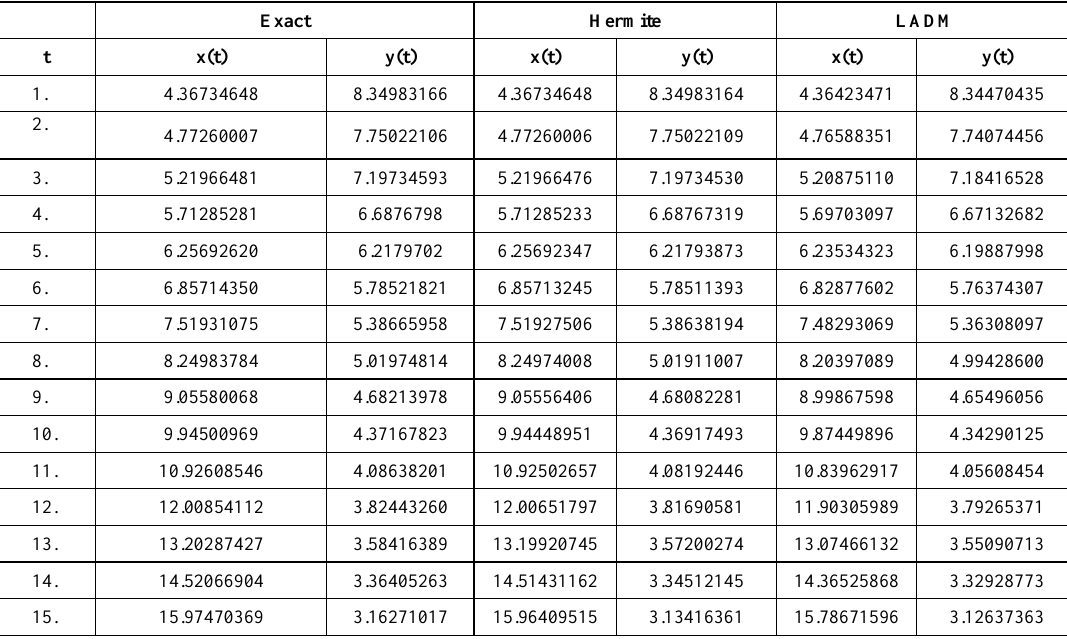
Table 3. Numerical comparison of exact solution and present method